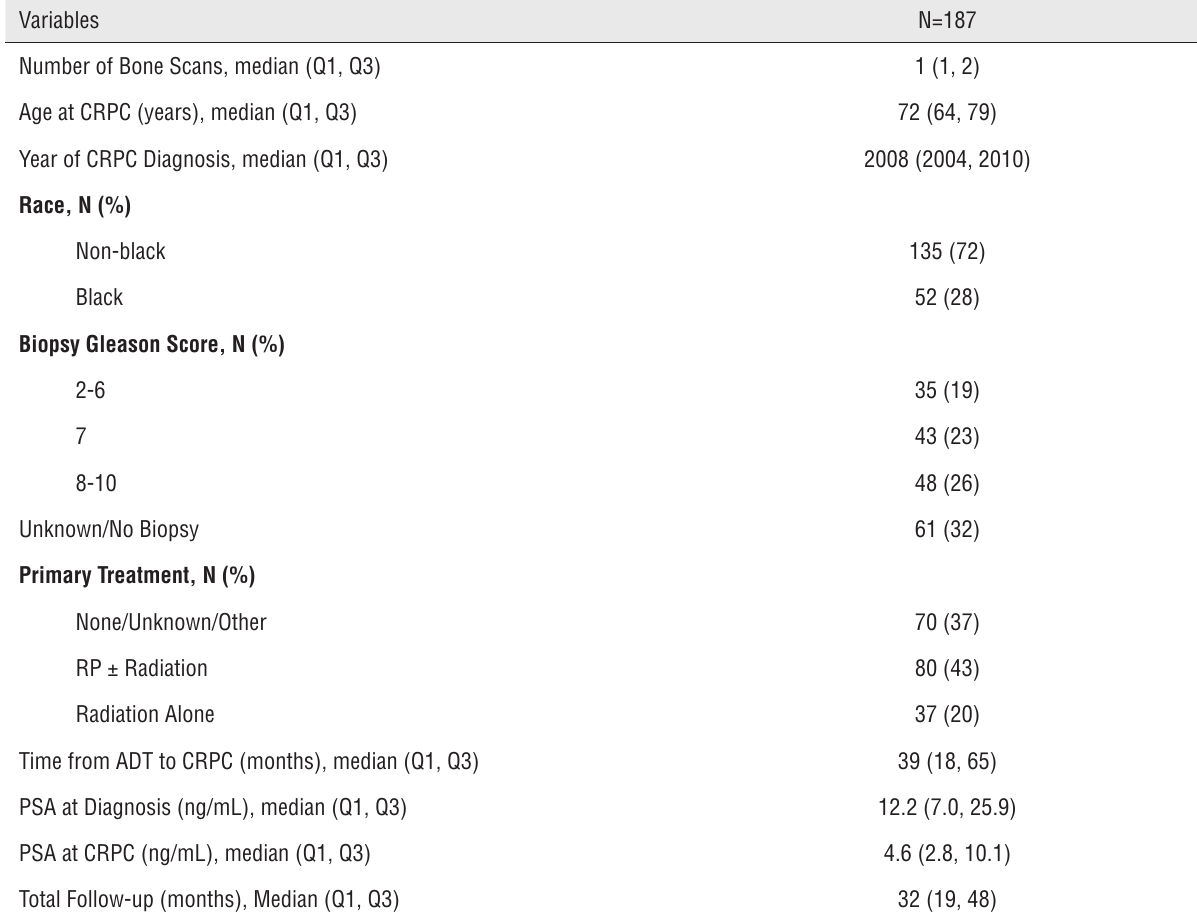
Table 1 - Baseline Patient